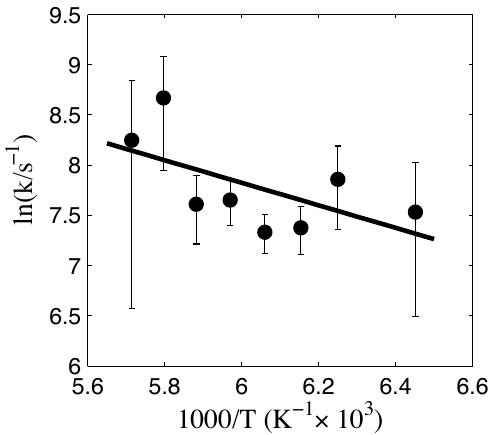
Fig. 5. Arrhenius plot of the rate coefficients for desorption of D 2 O from butanol covered ice for T = 155K to 175K. At higher temperatures the decay is too fast for the experimental resolution ( k (cid:29) 10 4 s − 1 ). The solid line is a linear least-squares fit to all of the points with a slope corresponding to E a = 0 . 1 ± 0 . 1eV and a pre- exponential factor A = 2 . 08 × 10 6 ± 3 s − 1